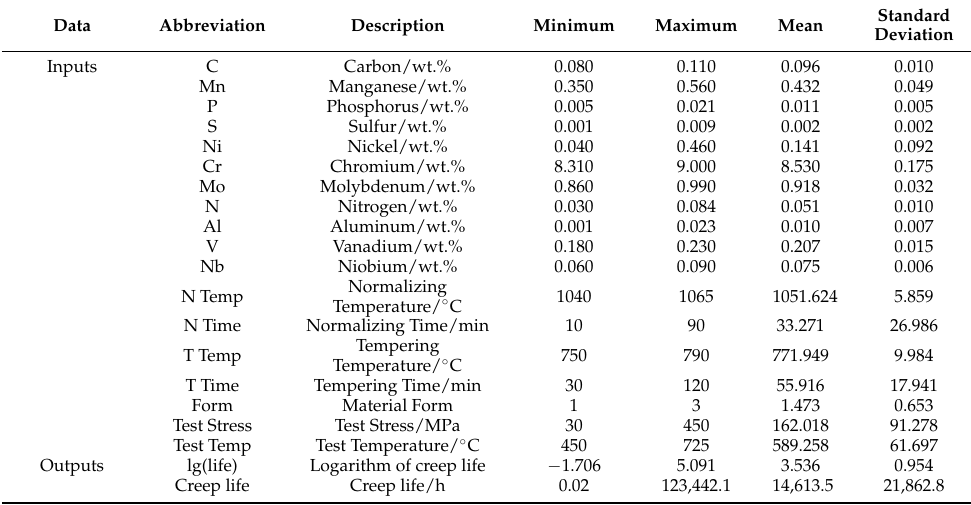
Table 1. Summary of the statistical description of collected